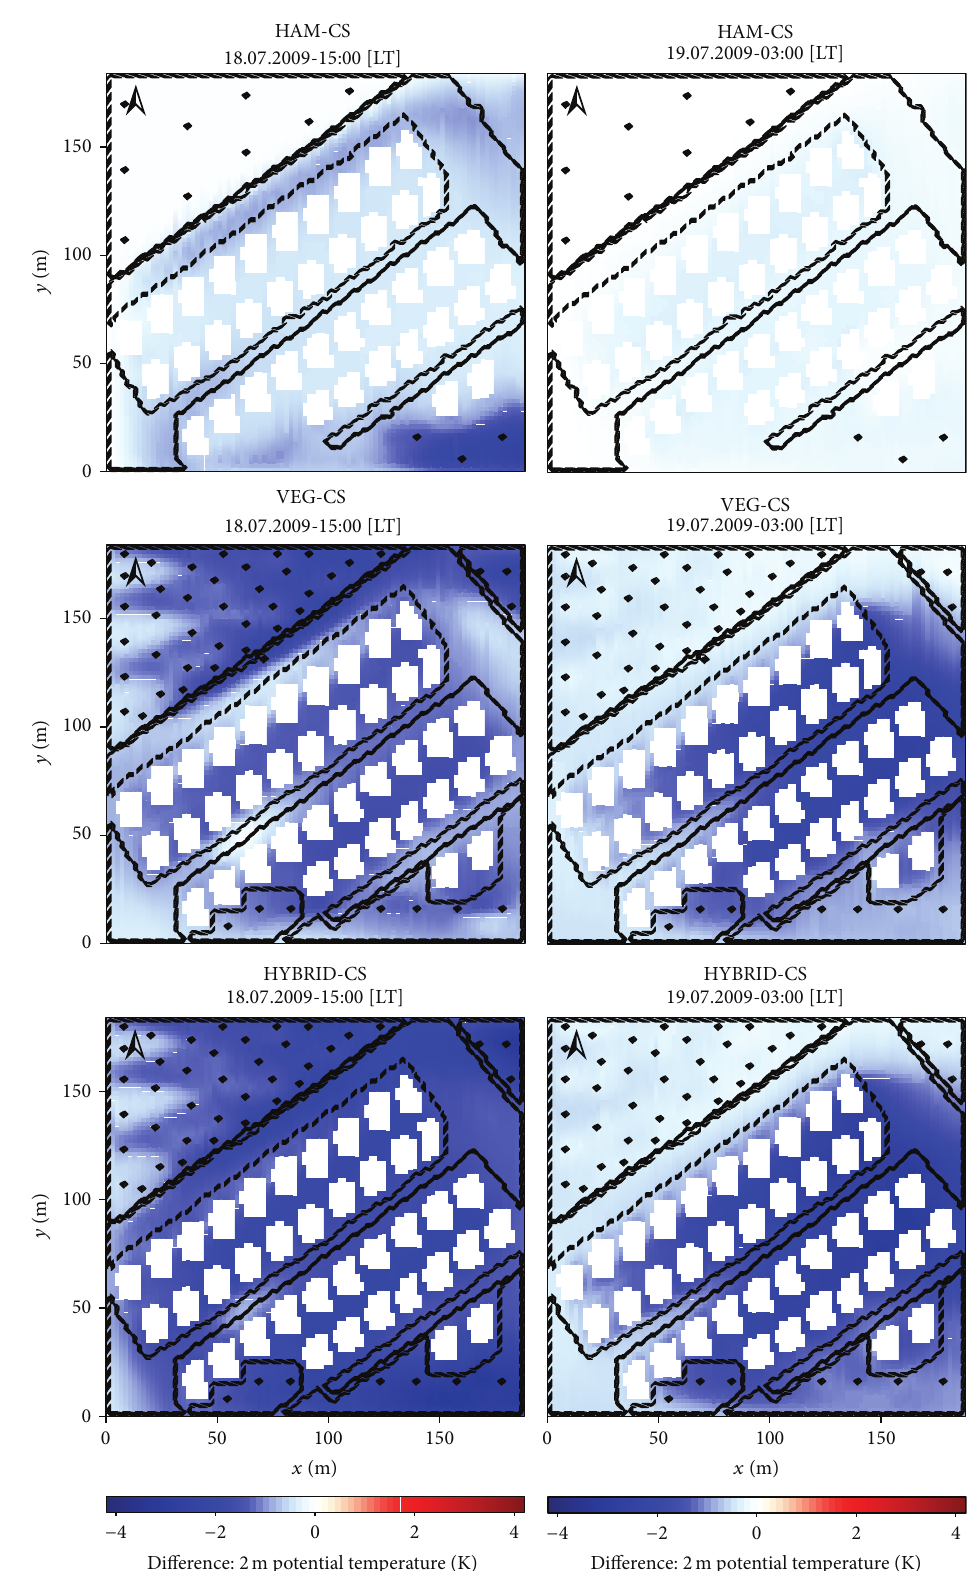
Figure 12: Potential temperature difference between CS and each UHI mitigation scenario at 15:00 and 03:00 h local